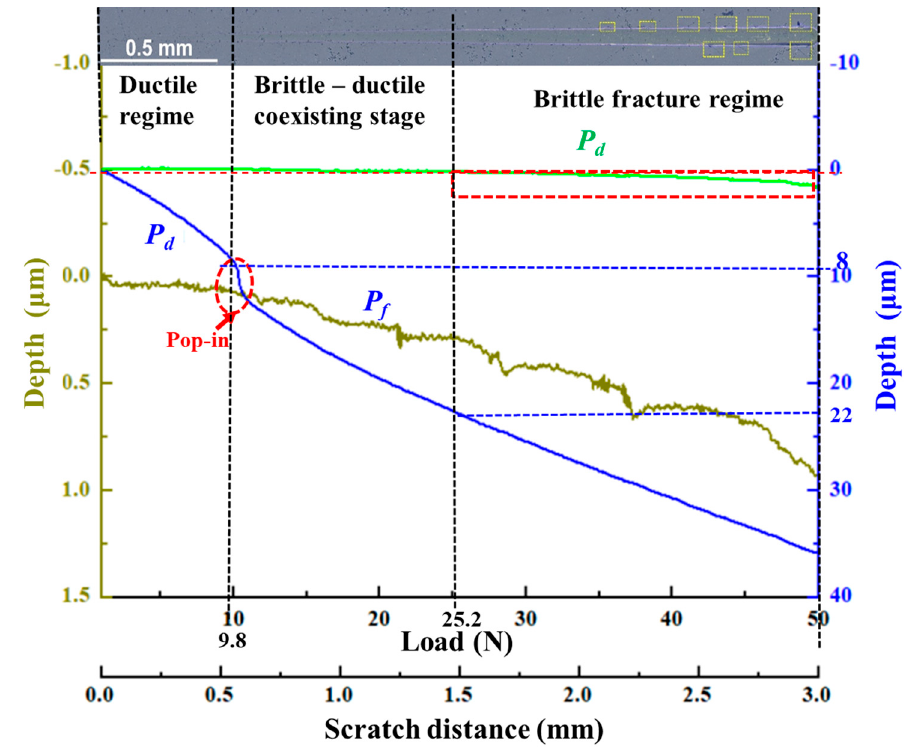
Figure 4. The P d , R d , and P f curves in the scratching experiment (1 – 50 N loading).